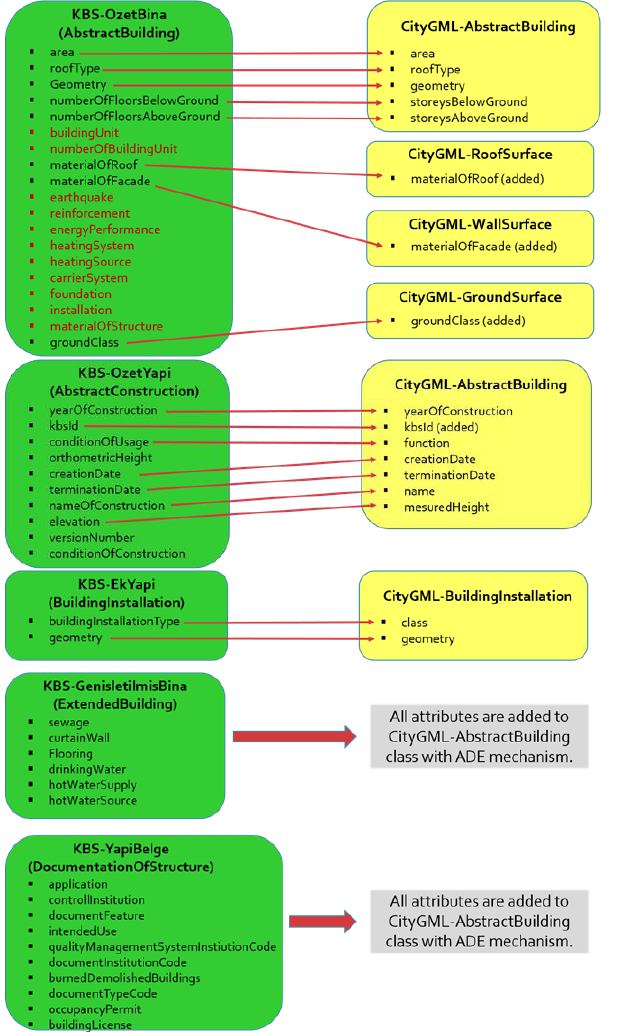
Figure 4. Mapping between TRKBIS and CityGML data themes (Attributes marked with red in TRKBIS-AbstractBuilding are added to CityGML-AbstractBuilding with ADE mechanism). Classes that are existing in TRKBIS model but not in CityGML are added as new classes as a subclasses of current CityGML